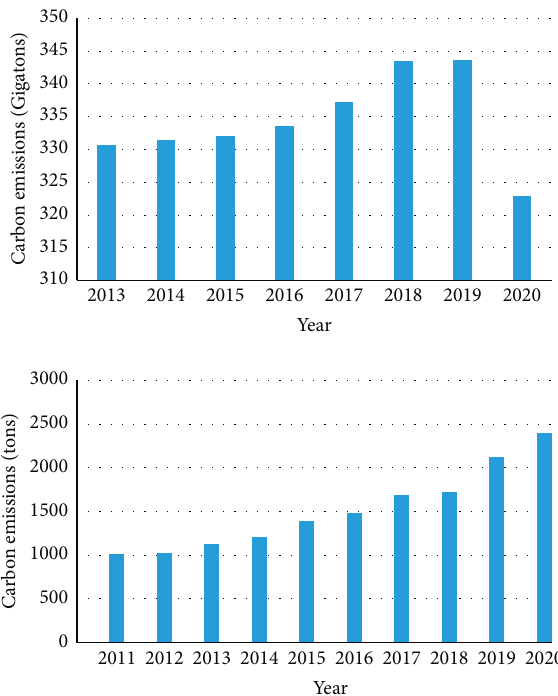
Figure 6: Total global carbon emissions in recent years.